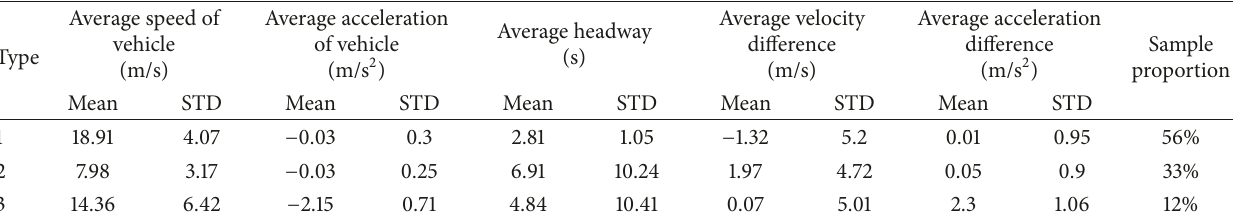
Table 2: The distribution of feature vector of different driving types in a congested traffic